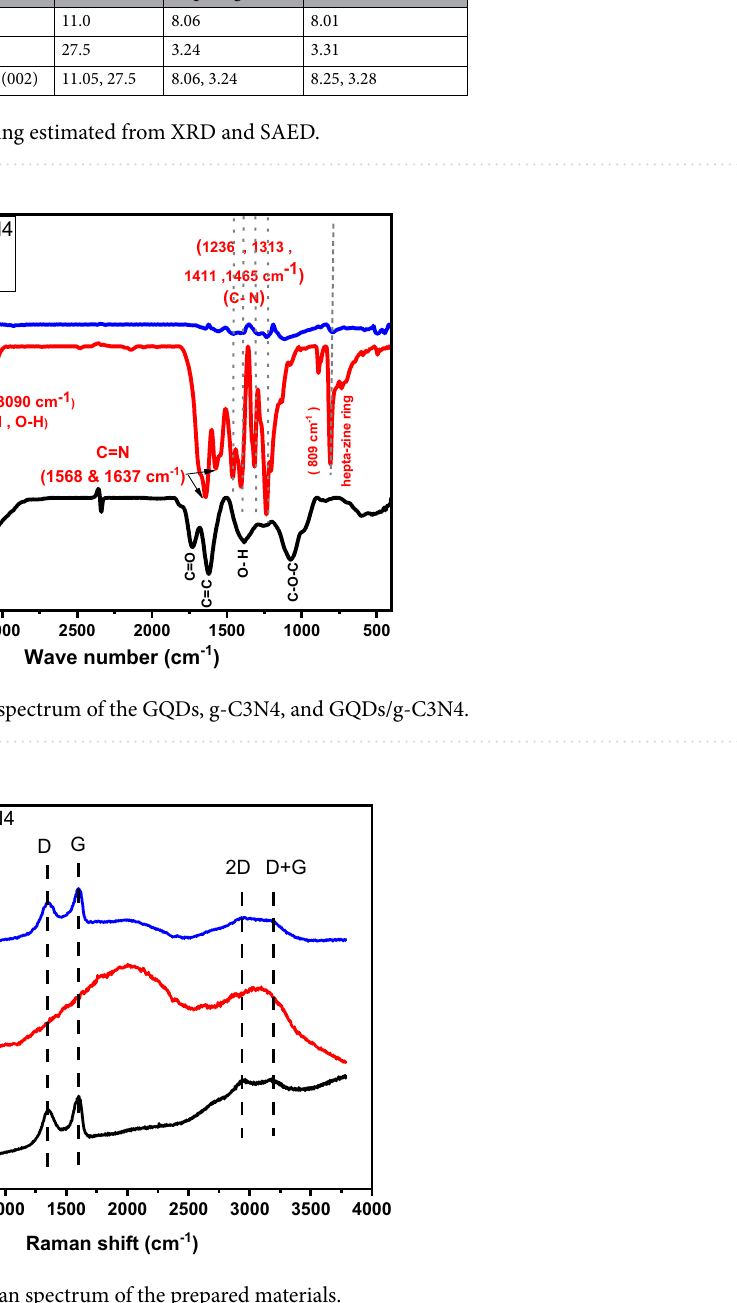
Figure 10. The Raman spectrum of the prepared